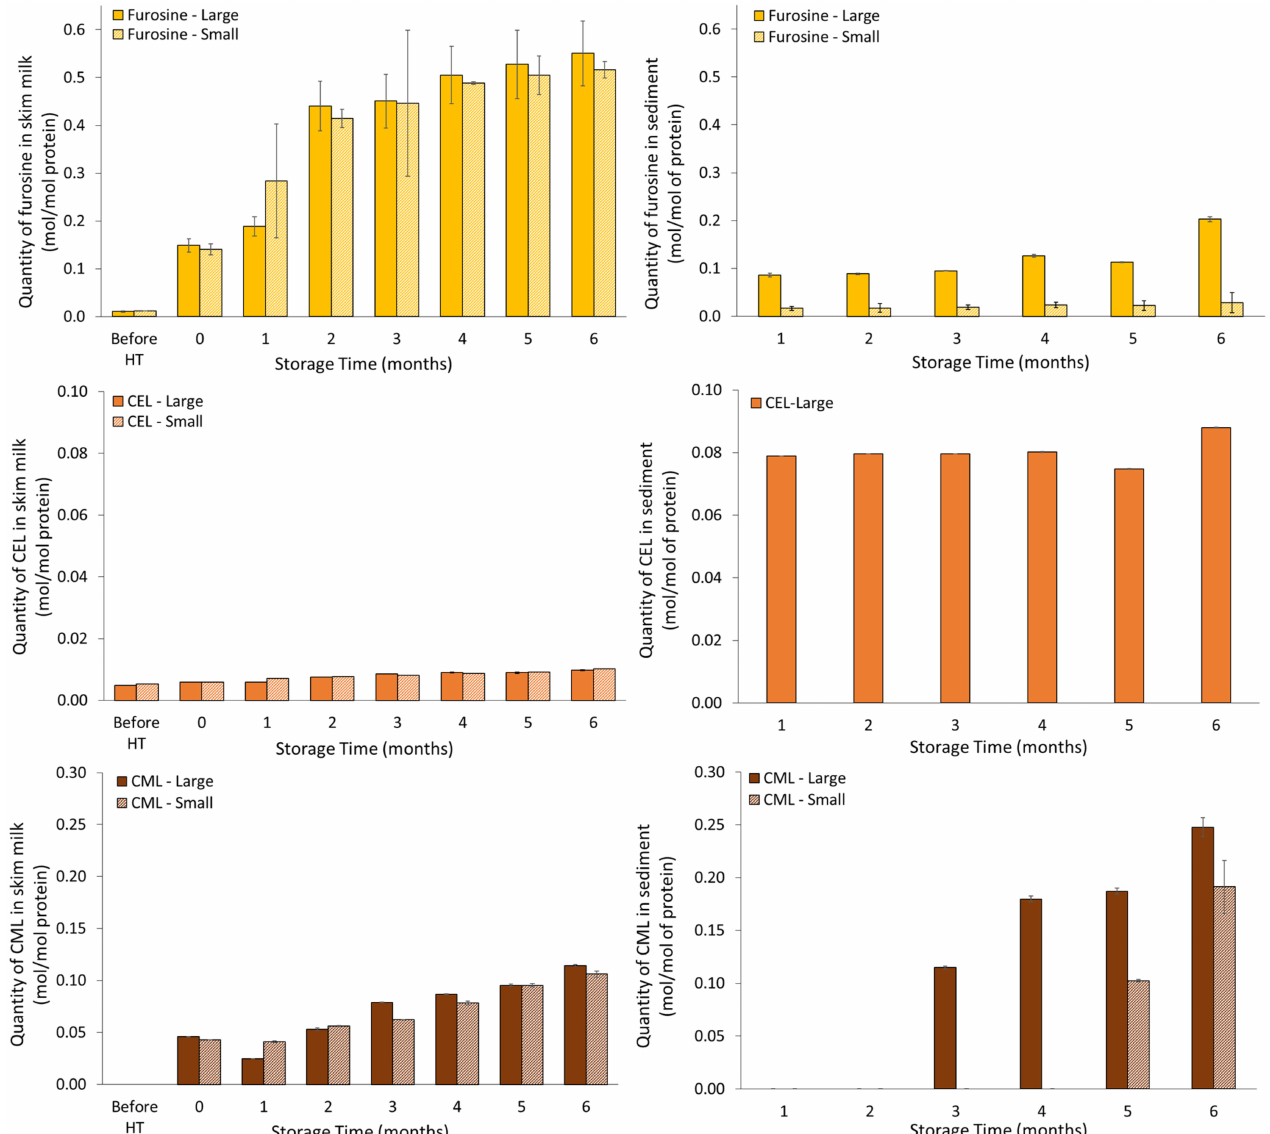
Figure 1. Development in molar levels of furosine, CEL and CML in UHT milk for ( left ) skim milk and ( right ) sediment, representing milk pools with either large or small casein micelles during storage at 40 ◦ C. CEL was below quantification limit on sediment for milk with small casein micelles. ‘Large’ and ‘Small’ indicate UHT milk prepared from raw milk representing large or small casein micelles,